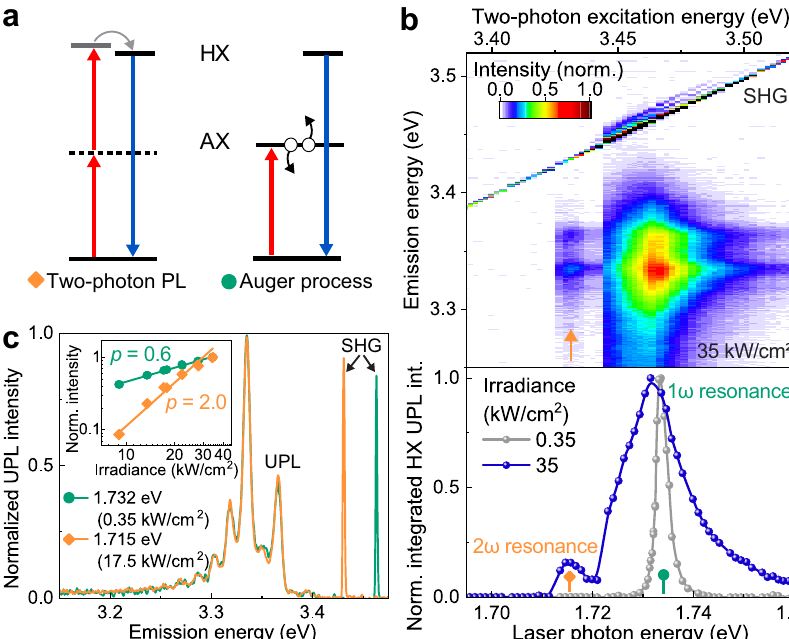
Fig. 3 Excitation pathways of the high-lying exciton HX. a The HX can be formed either by two-photon absorption (TPA) involving a virtual level (dashed) or by Auger-like exciton-exciton annihilation (black arrows) of the A-exciton AX. TPA populates a dark p -like HX state, which subsequently relaxes (gray arrow) to the bright s -like HX state. b Change of the UPL spectrum with a photon energy of the CW laser at an irradiance of 35 kW/cm 2 , showing TPA (arrow) below the onset of the Auger-like double-exciton process. The diagonal line stems from SHG from the WSe 2 monolayer. The spectrally integrated HX UPL intensity is plotted as a function of excitation energy in the lower panel. TPA (2 ω resonance) is observed at a pump intensity of 35 kW/cm 2 , while only the one-photon (1 ω ) resonance is observed at 0.35 kW/cm 2 . c The two excitation mechanisms are distinguished by their power dependencies (inset). For the Auger-like mechanism (green), excitation in resonance with the band-edge A-exciton at 1.732 eV gives a sublinear dependence of UPL intensity on excitation power because of bleaching of the A-exciton transition. The corresponding power-law exponent p is about 0.6. Sub-resonant excitation at 1.715 eV yields the parabolic power dependence characteristic of TPA (orange). The corresponding power-law exponent is close to 2.0. The HX PL spectrum is independent of the excitation pathway (green and orange